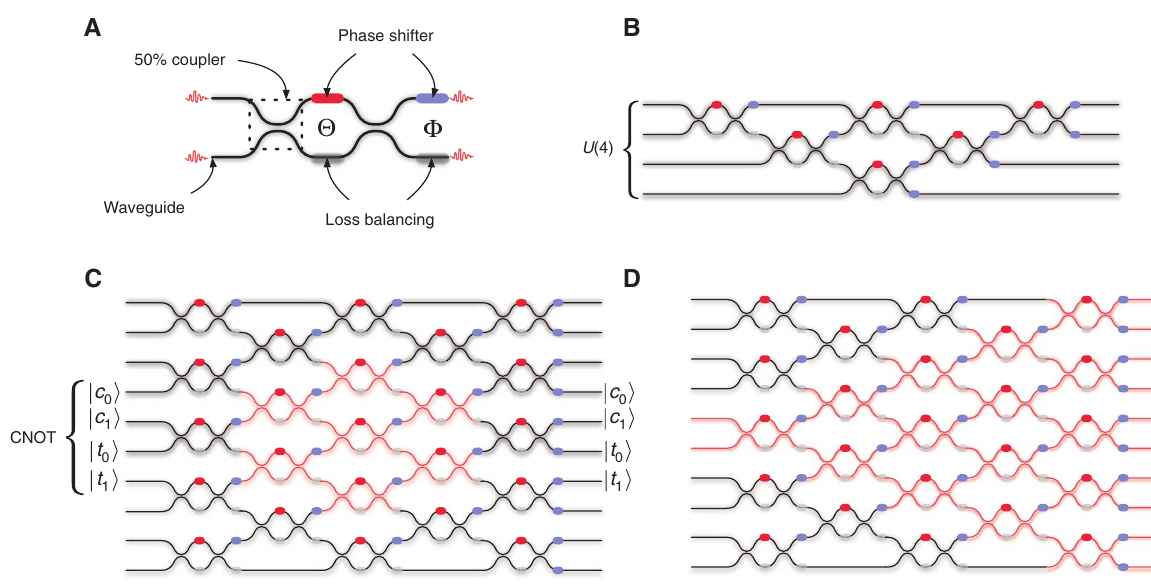
Figure 2: A programmable photonic circuit. (A) RBS unit cell. (B) Mesh of RBS unit cells implementing an arbitrary four-dimensional, single- particle unitary transformation. (C) Footprint for an embedded postselected CNOT gate with control and target modes labeled as | c | t 〉, respectively [28]. (D) Footprint of circuit for exploring quantum transport phenomena [49]. 0,1